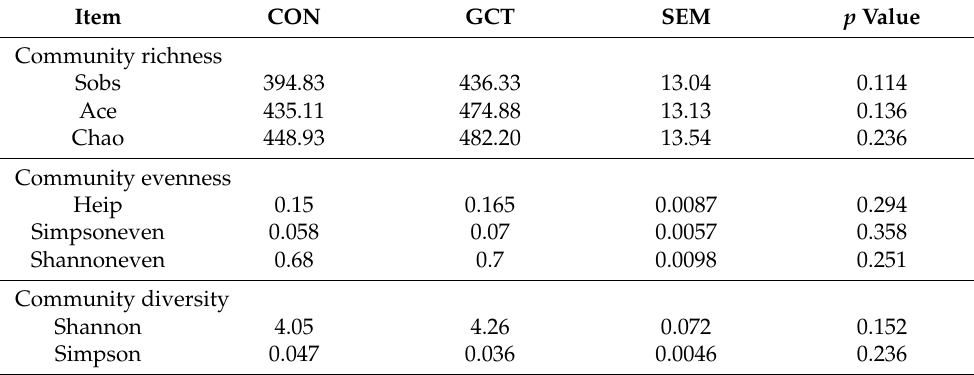
Table 6. Effects of GCT on community richness, evenness, and diversity of cecum intestinal